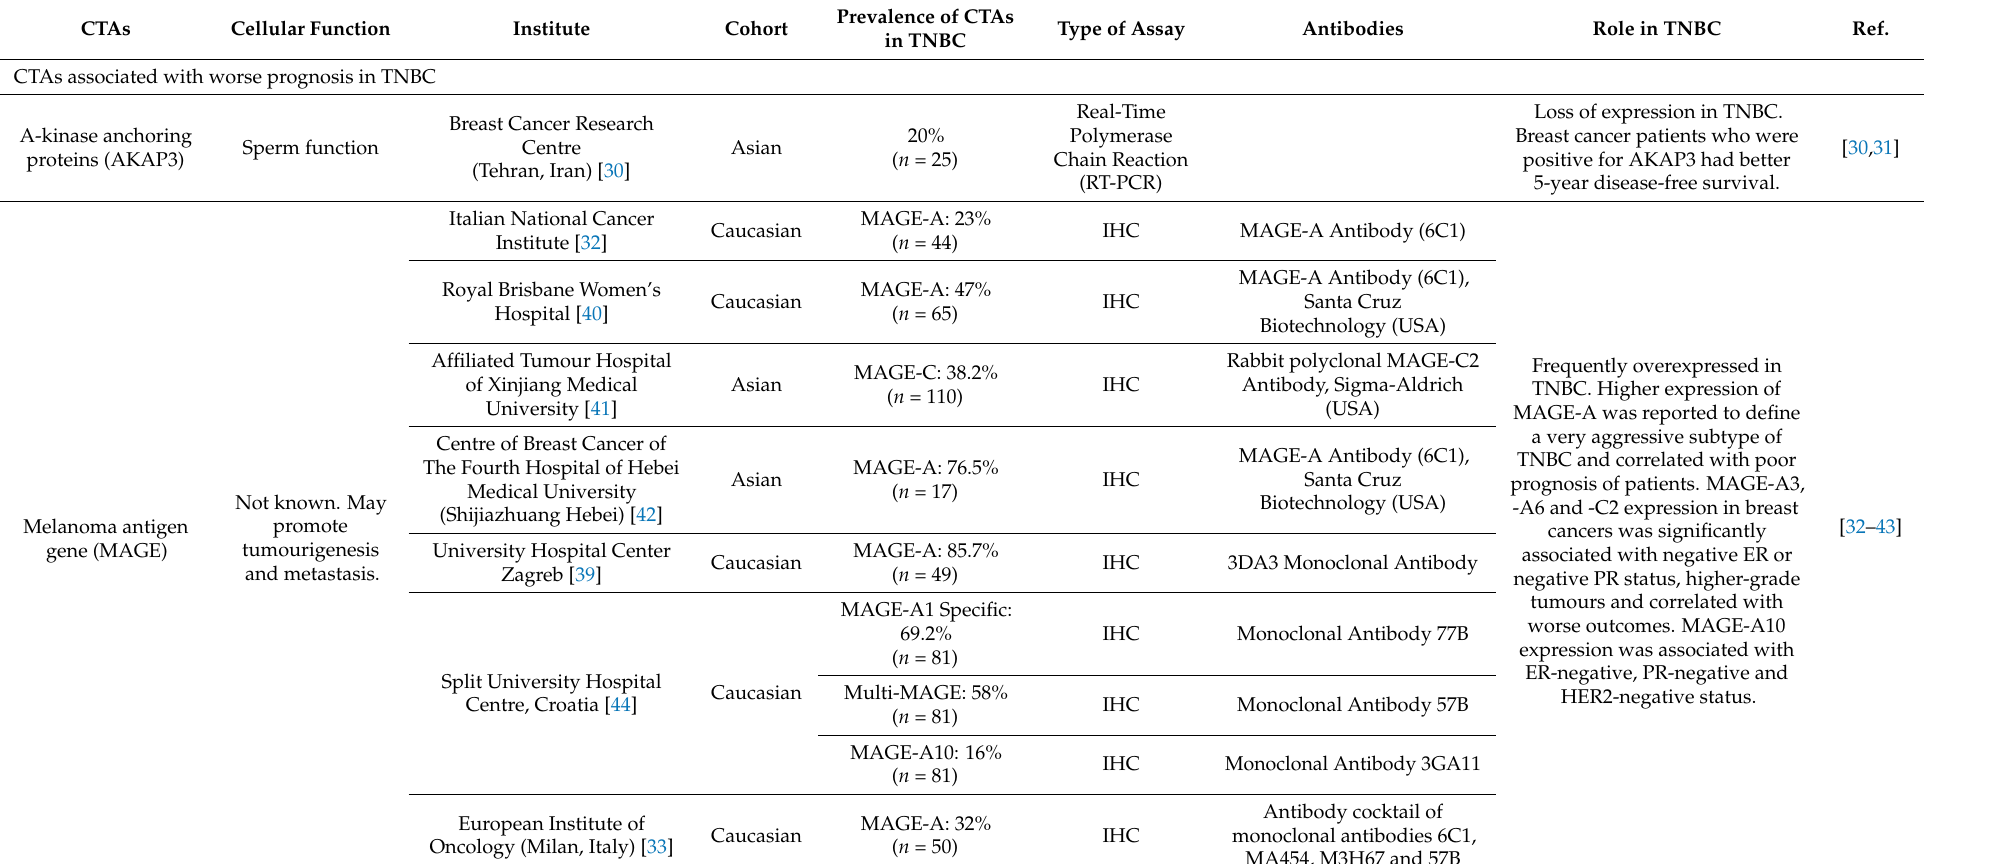
Table 1. Summary of CTAs in